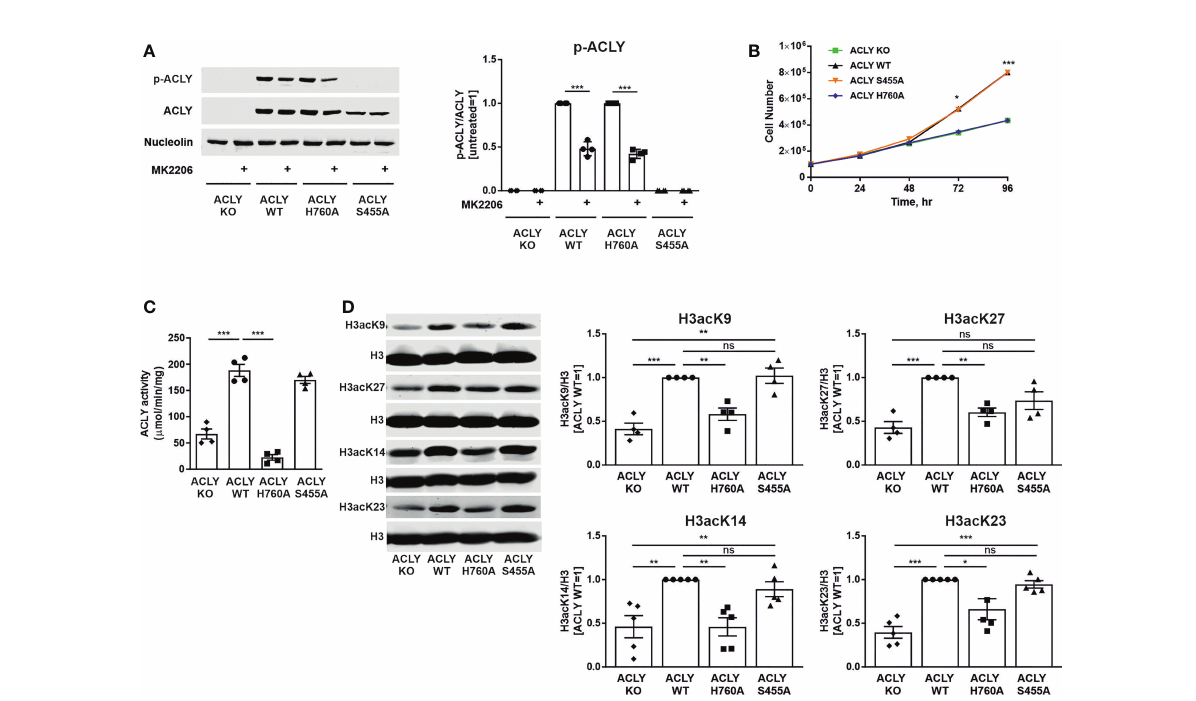
FIGURE 1 ACLY knockout and catalytically inactive H760A mutant cell lines show impaired growth and reduced basal histone acetylation. (A) Western blot analysis of ACLY phosphorylation upon treatment with 10 m M MK2206 for 30 minutes. (B) Growth curves. (C) ACLY enzymatic activity. (D) Basal histone H3 acetylation expression at K9, K27, K14 and K23 in ACLY knockout (KO), WT, H760A and S455A THP-1 cells. Data represent mean values ± SE of 3-5 independent experiments. * p<0.05, ** p<0.01, *** p<0.001, ns, non signi fi